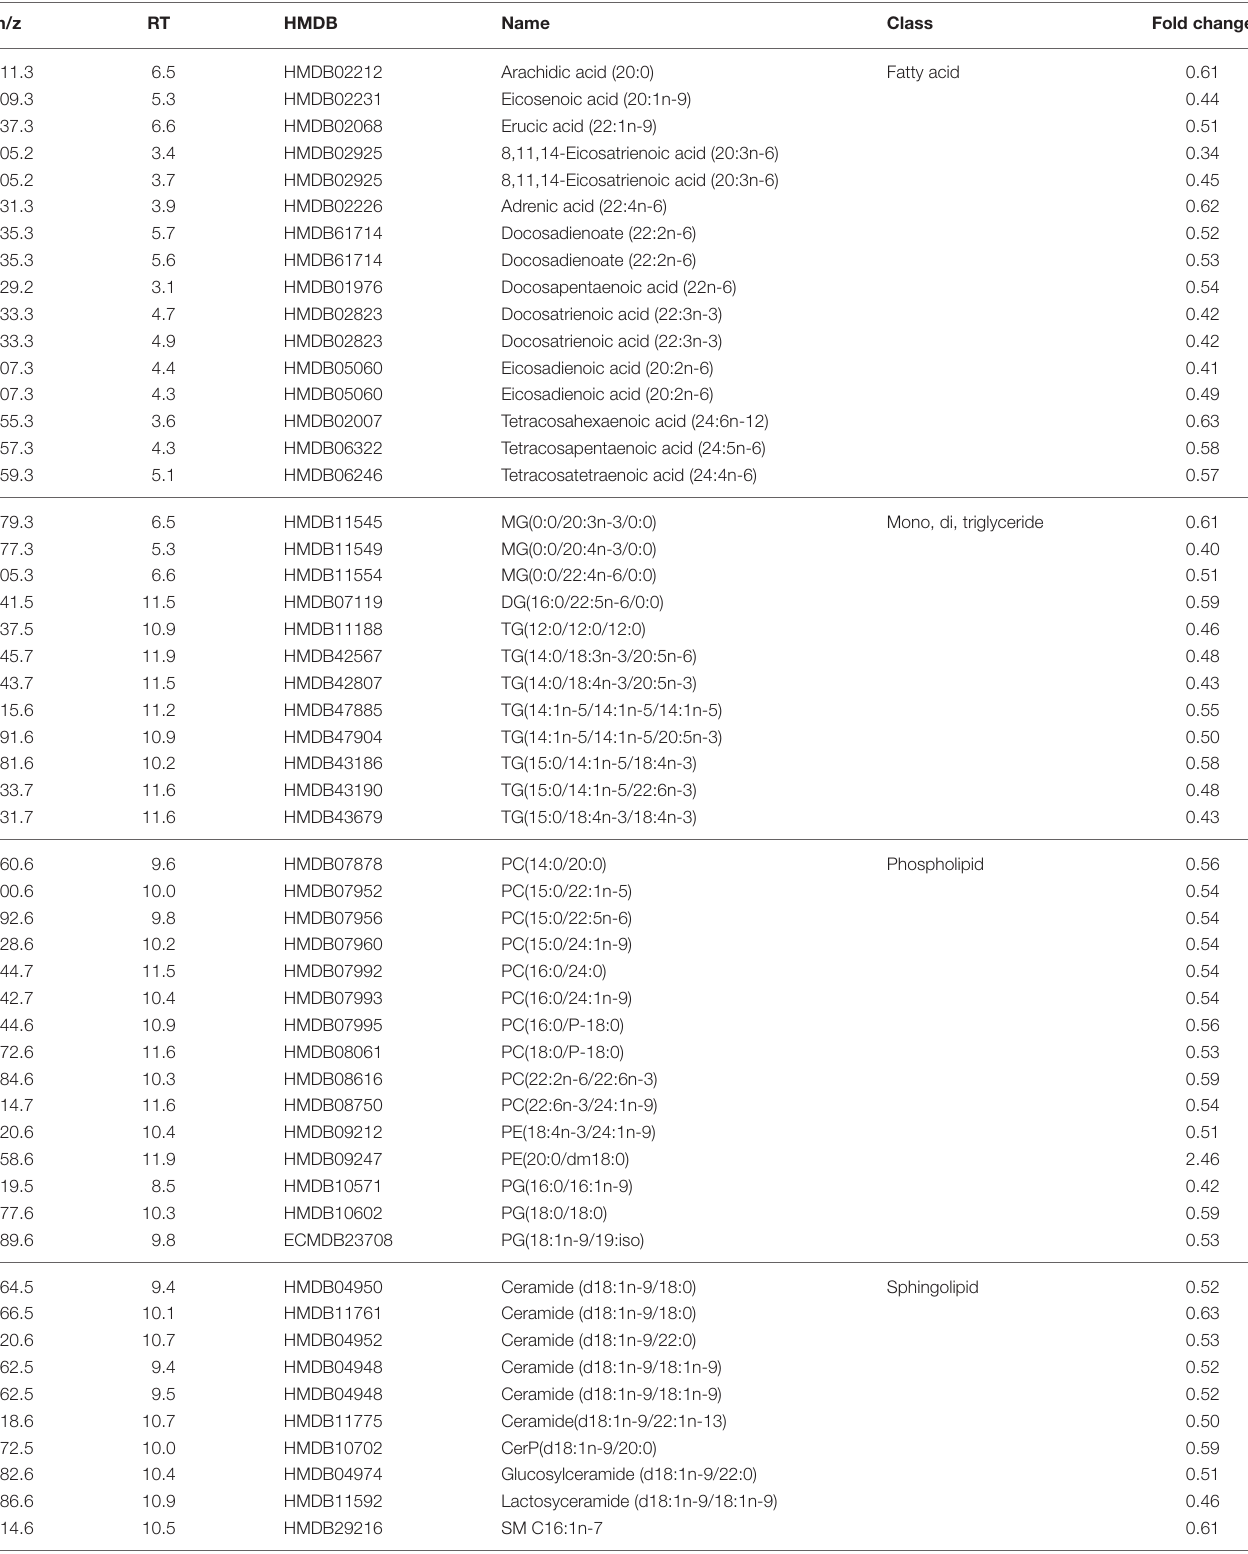
TABLE 4 | Dysregulation of lipid metabolites in the spinal cord of SOD1 G86R mice, after negative ionization, and tentative identification.